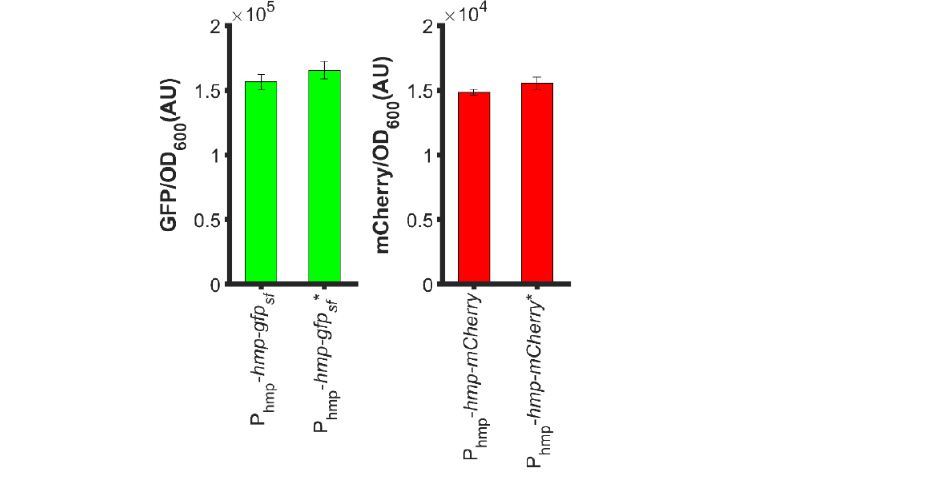
Figure 7. Second start codons of the translational fusions did not impact expression levels appreciably. ( Left ): GFP fluorescence normalized by OD 600 after subtraction of the background signal (wild-type harboring pUA66) of exponential-phase Δ nsrR E. coli harboring pUA66-P hmp - hmp-gfp sf (pXW01) and pUA66-P hmp - hmp-gfp sf * (pXW04, start codon of gfp sf removed); ( Right ): mCherry fluorescence normalized by OD 600 after subtraction of the background signal (wild-type harboring pUA66) of exponential-phase Δ nsrR E. coli harboring pUA66-P hmp - hmp-mCherry (pXW05) and pUA66-P hmp - hmp-mCherry * (pXW07, start codon of mCherry removed). Data are the means of three independent replicates, and error bars represent the standard errors of the means.